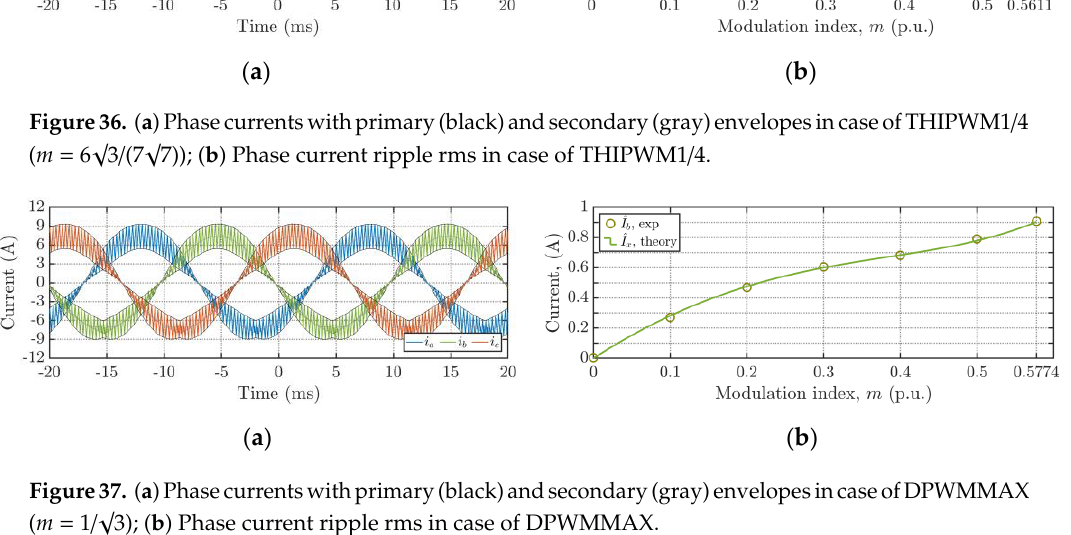
Figure 37. ( a ) Phase currents with primary (black) and secondary (gray) envelopes in case of DPWMMAX ( m = 1/√3); ( b ) Phase current ripple rms in case of DPWMMAX. Figure37. ( a )Phasecurrentswithprimary(black)andsecondary(gray)envelopesincaseofDPWMMAX √ DPWMMAX ( m = 1/√3); ( b ) Phase current ripple rms in case of DPWMMAX. ( m = 1 / 3); ( b ) Phase current ripple rms in case of DPWMMAX.